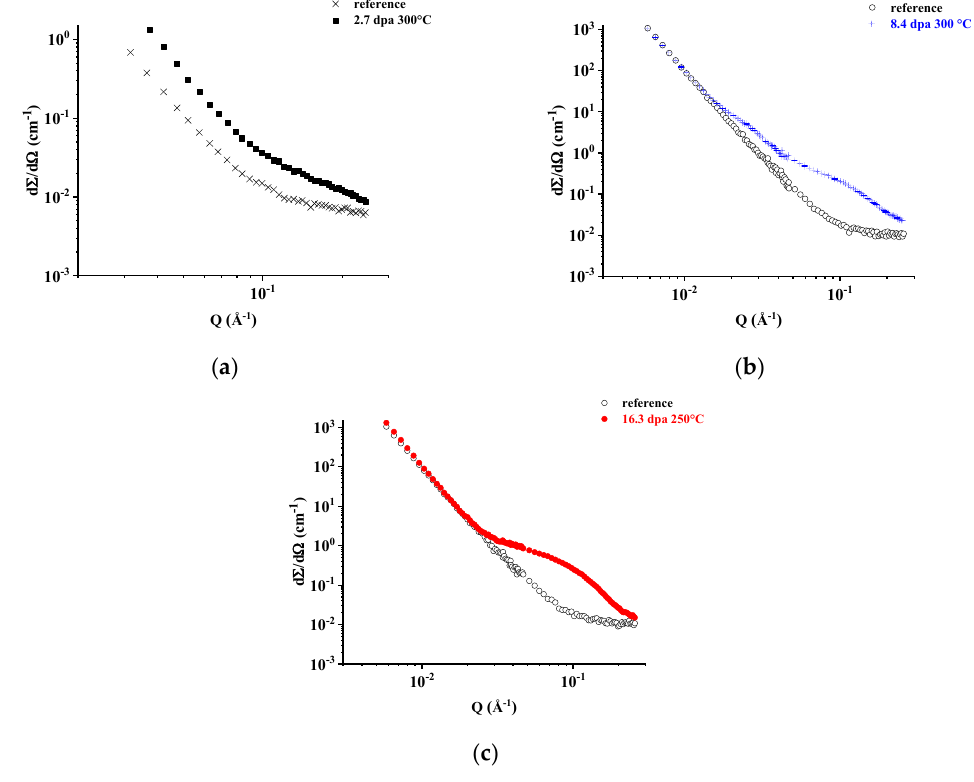
Figure 5. Nuclear SANS cross-sections for Eurofer97: ( a ) irradiated 2.7 dpa 300 °C (squares) and reference ( x crosses) [10], ( b ) irradiated 8.4 dpa 300 °C (+ crosses) and reference (empty circles) [14], ( c ) irradiated 16.3 dpa 250 °C (full circles) and reference (empty circles) [14].